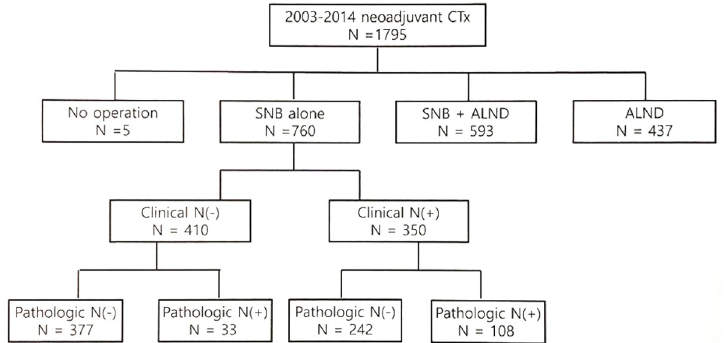
Fig 1. Flow diagram of the patient selection process. CTx chemotherapy, SLNB sentinel lymph node biopsy, ALND axillary lymph node dissection.